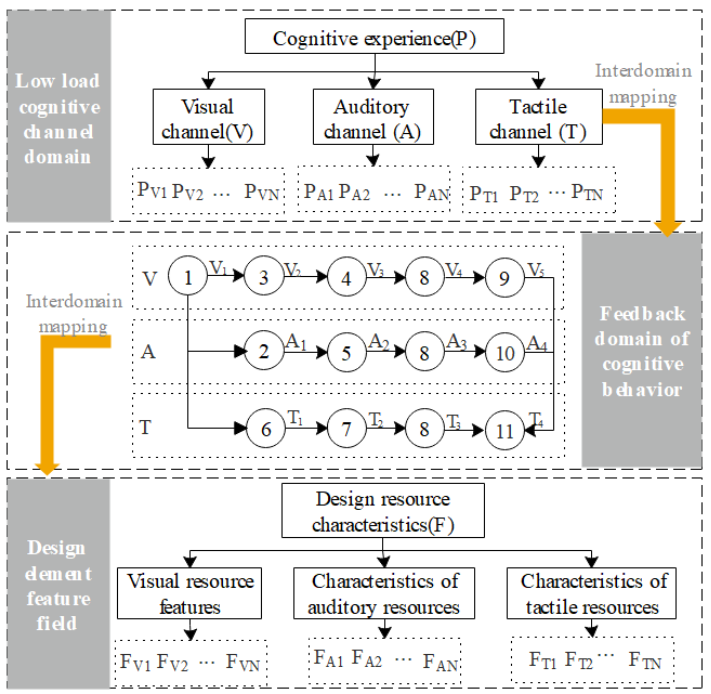
Figure 3. Cognitive behavior-design feature model.